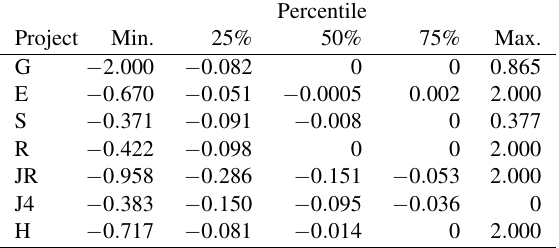
Table 7. Distributions of Δ NIPA ( v ) .